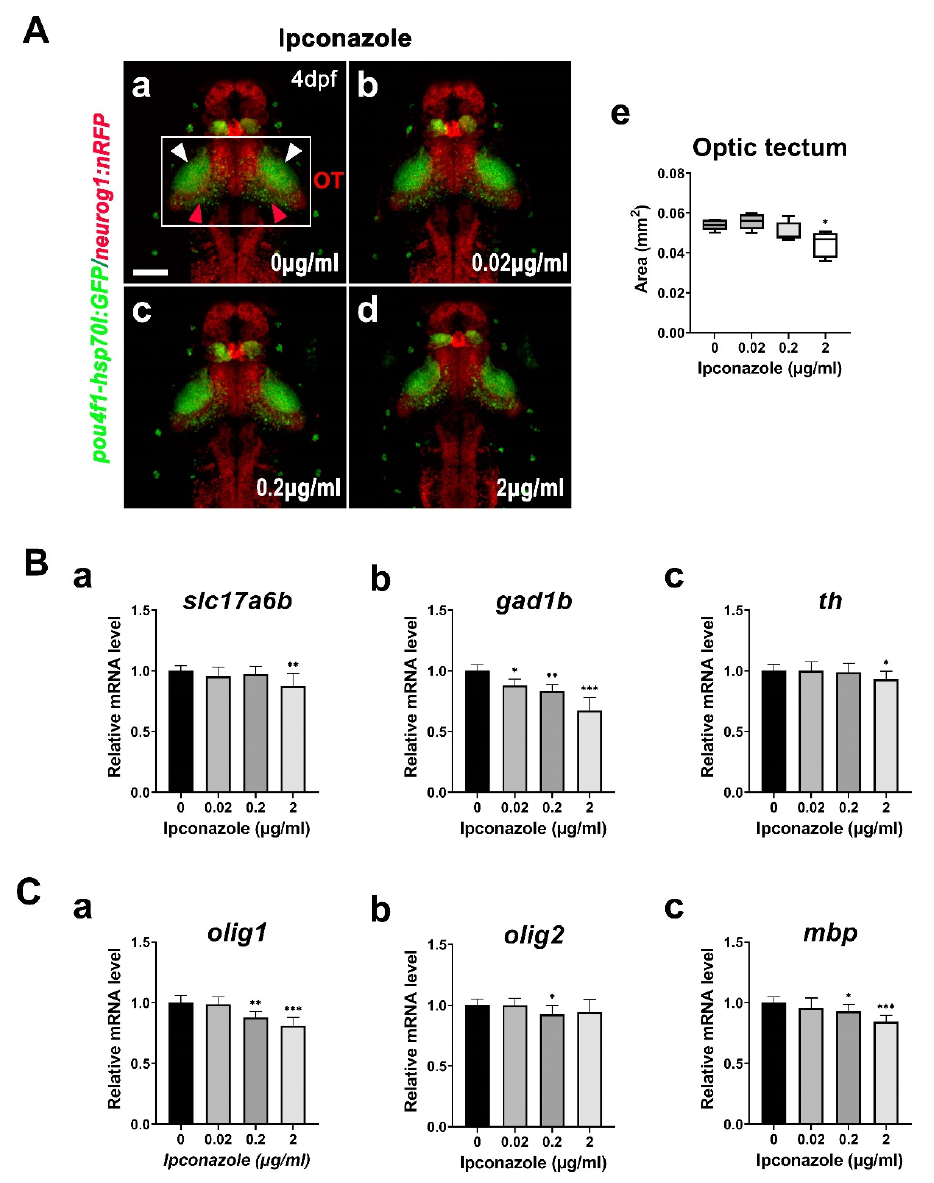
Figure 5. Ipconazole preferentially alters the development of GABAergic neurons. ( A ) Dorsal views of the brain of the 4-dpf larvae of Tg(pou4f1-hsp70l: GFP) rw0110b and Tg(-8.4neurog1:nRFP) sb3 transgenic fish using confocal microscopy ( a – d ) and the size analysis of the optic tectum in the embryos treated with ipconazole ( e ). White box, optic tectum (OT); white arrowhead, neuropil; red arrowhead, periventricular layer, scale bar, 100 μ m; ( B ) mRNA expressions of the following neuronal markers in the 3-dpf embryos using RT-PCR: slc17a6b for excitatory glutamatergic neurons ( a ), gad1b for GA- BAergic inhibitory neurons ( b ), and th for dopaminergic neurons ( c ); ( C ) mRNA expressions of the following glial cell markers: olig1 and olig2 for oligodendrocyte formation ( a , b ) and mbp for mye- lination ( c ) in the 3-dpf embryos. * p < 0.05, ** p < 0.01, *** p < 0.001. We next monitored the molecular changes in the following gene expressions during the development of excitatory neurons, inhibitory neurons, and dopaminergic neurons in the brain of 3-dpf larvae treated with ipconazole: slc17a6b ( solute carrier family 17 member